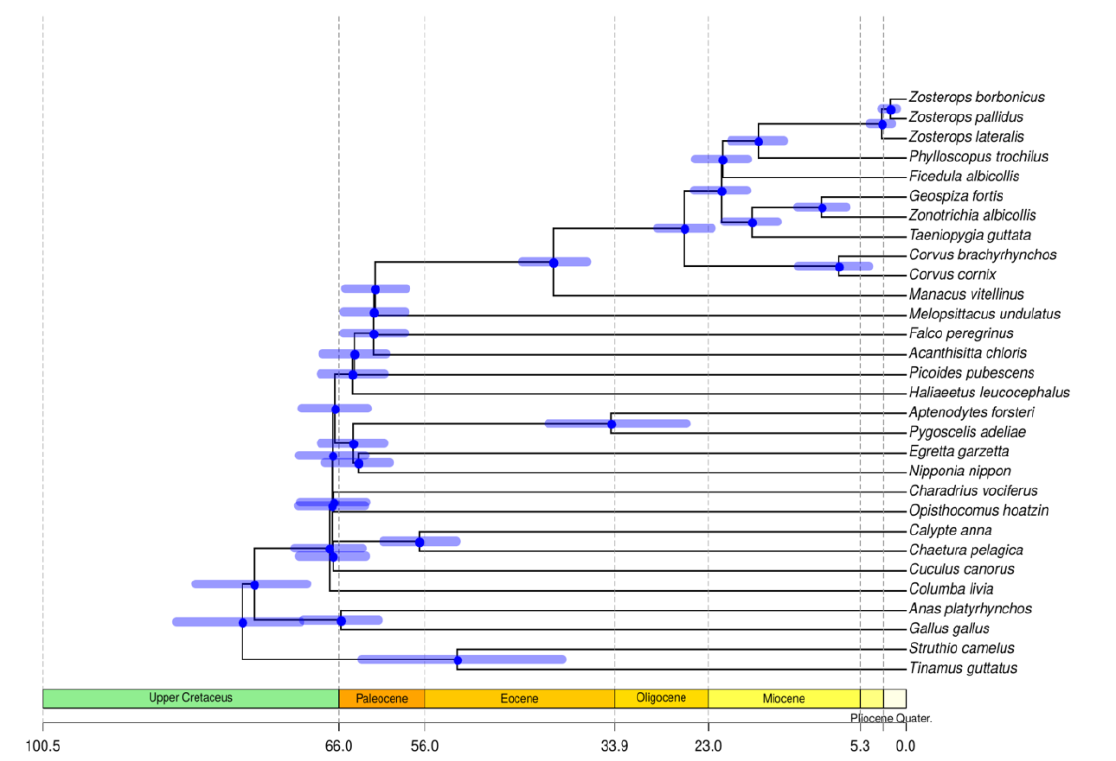
Figure S3. Molecular dating of the 30 birds species. Molecular dating estimates are based on the dataset 1 with CAT GTR substitution model, log-normal molecular rate model and calibration set 1 (Table